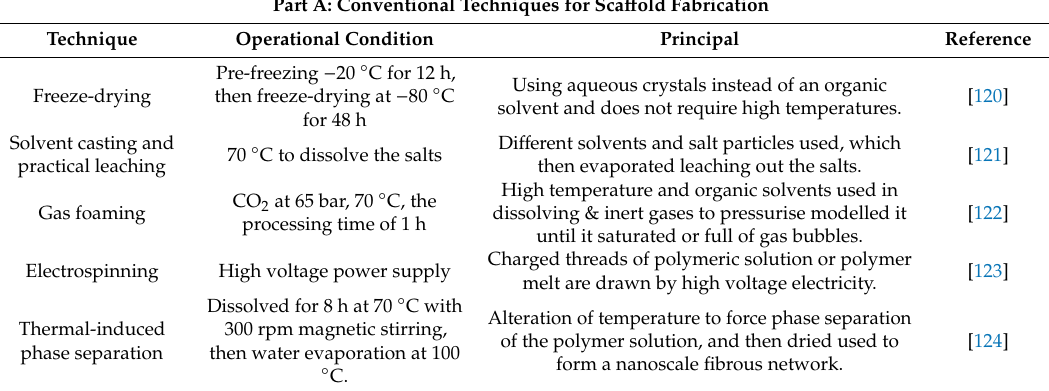
Table 6. Conventional and rapid prototyping techniques for sca ff old fabrication of micro- and nanocellulose-based